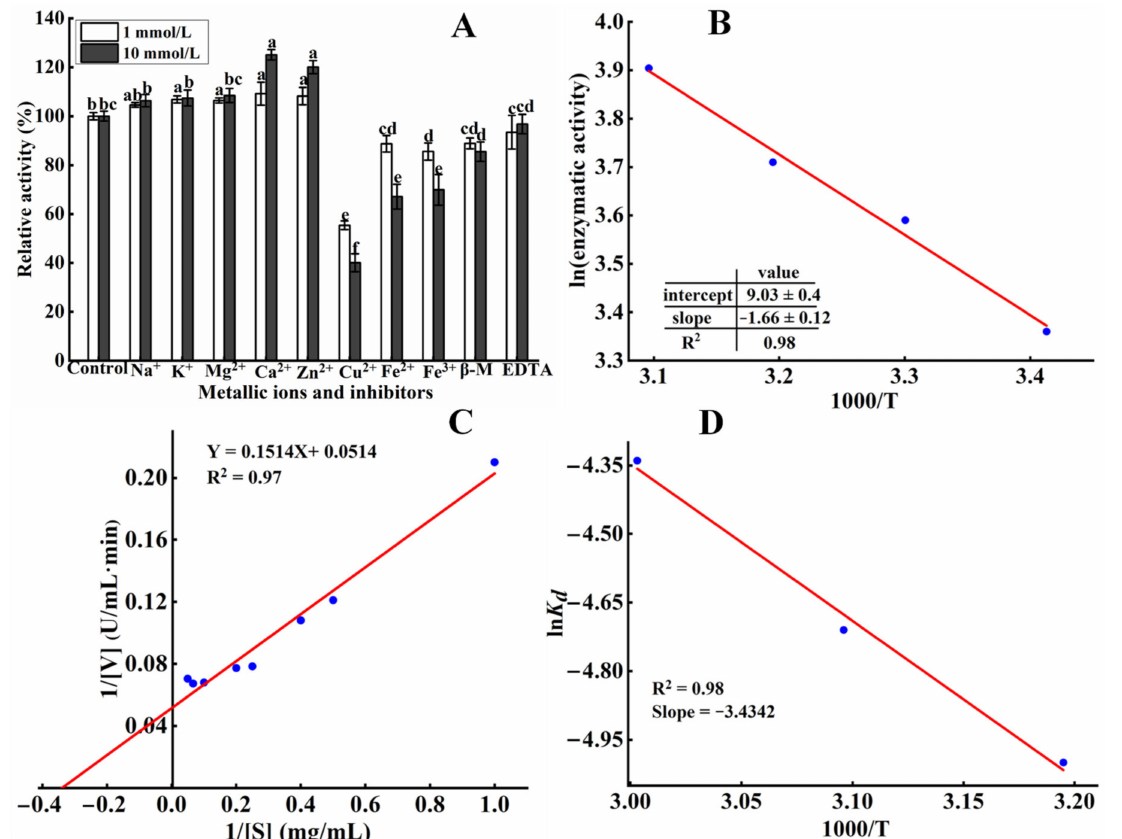
Figure 4. ( A ) Influence of metallic ions and inhibitors on the S. xylosus A2 protease activity. Different letters in the same column represent significant differences in different samples ( p < 0.05). ( B ) Ar- rhenius plot of the S. xylosus A2 protease. ( C ) Lineweaver-Burk plot for the S. xylosus A2 protease using casein as the substrate. ( D ) Arrhenius plots for the thermal denaturation ( E a(d) ) of the S. xylosus A2